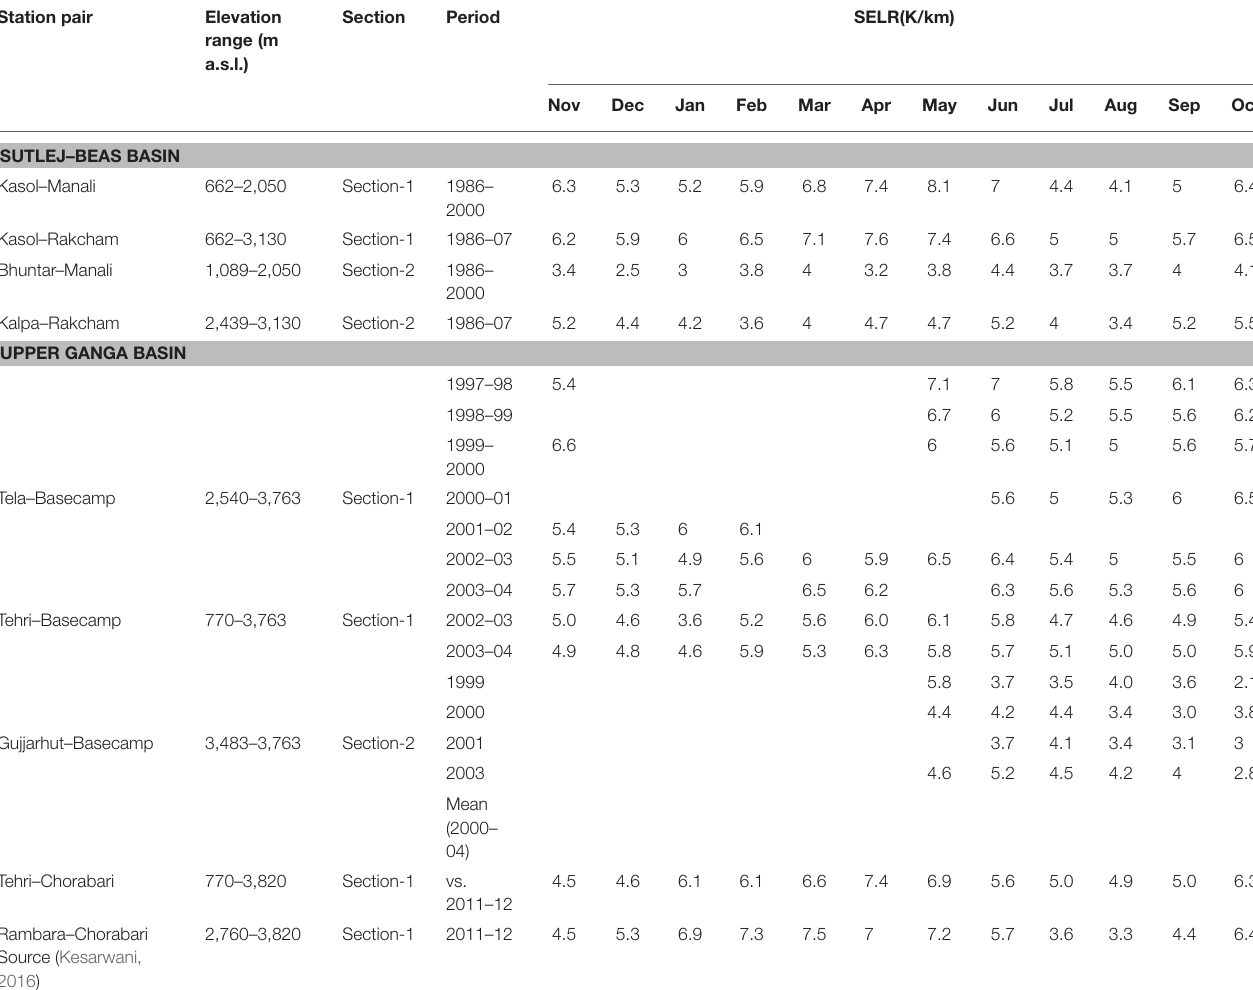
TABLE 1 | Slope Environmental Lapse rate (SELR) of temperature in the monsoon regime of western Himalaya along nine profiles covering Sutlej, Beas, and upper Ganga basins. Station